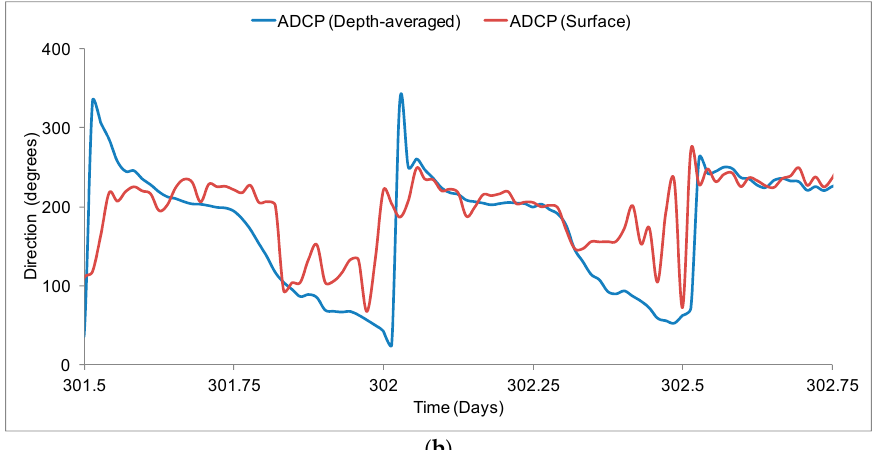
Figure 8. Depth-averaged and surface ADCP data (( a ) speed, ( b ) direction) at A2 during P2.